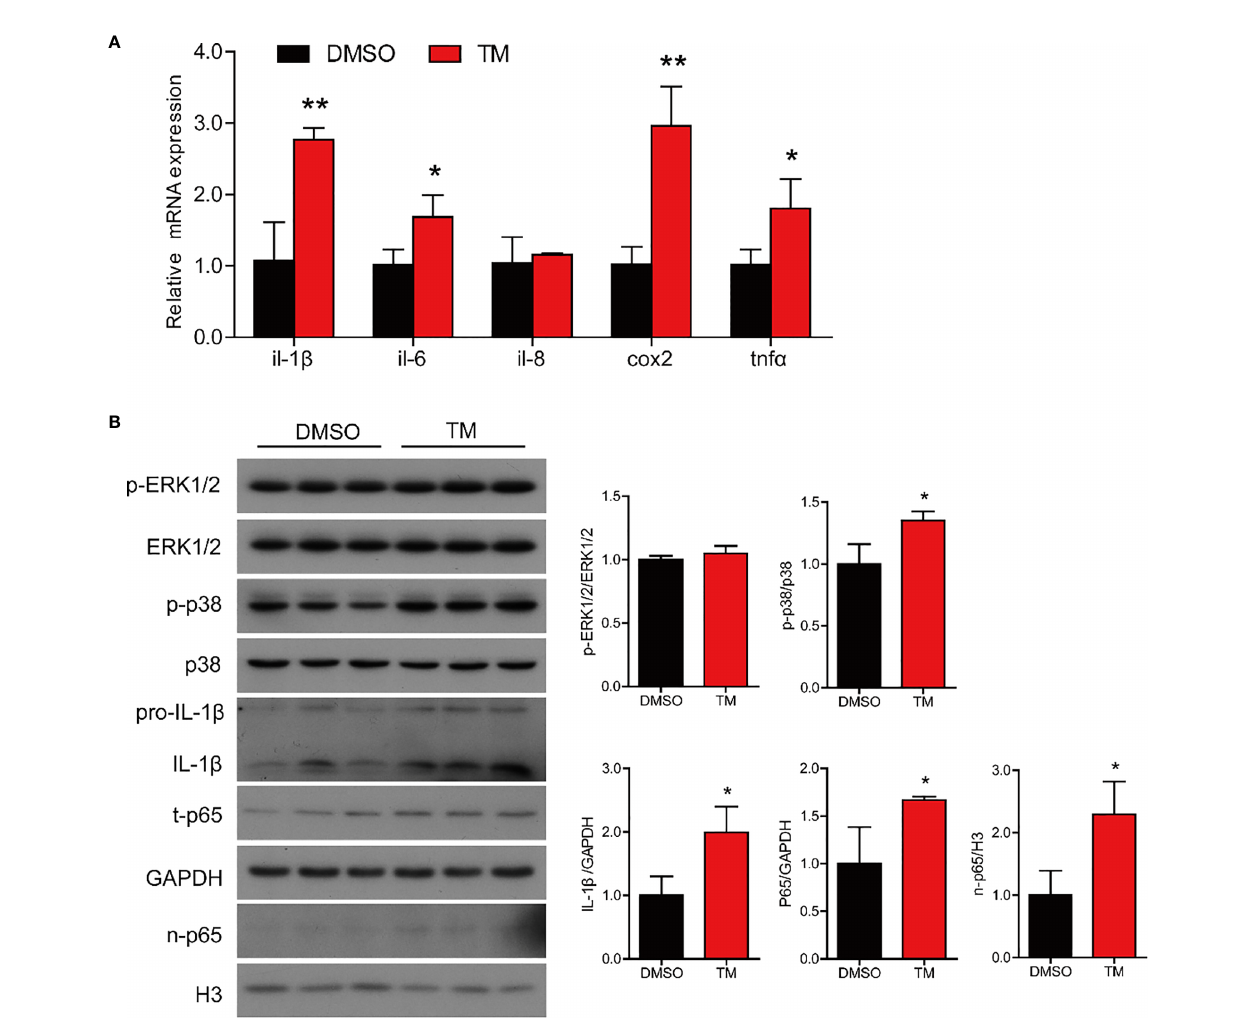
FIGURE 7 | ER stress augments in fl ammatory response in the isolated intestinal cells of large yellow croaker in vitro . (A) Relative mRNA expression of in fl ammation- related genes in the isolated intestinal cells of large yellow croaker after TM treatment for 12 h (n = 3). (B) Western blot analysis of in fl ammation-related protein levels in the isolated intestinal cells of large yellow croaker after TM treatment for 12 h (normalized to GAPDH, n = 3). il-1 b , interleukin-1 beta; il-6 , interleukin-6; il-8 , interleukin-8; cox2 , cyclooxygenase 2; tnf a , tumor necrosis factor alpha; ERK1/2, extracellular signal-regulated protein kinases 1 and 2; p38, p38 mitogen-activated protein kinase; p65, NF-kappaB p65; GAPDH, glyceraldehyde-3-phosphate dehydrogenase. Results were analyzed using independent t -test (* P < 0.05, ** P < 0.01), and they were presented as mean ± standard